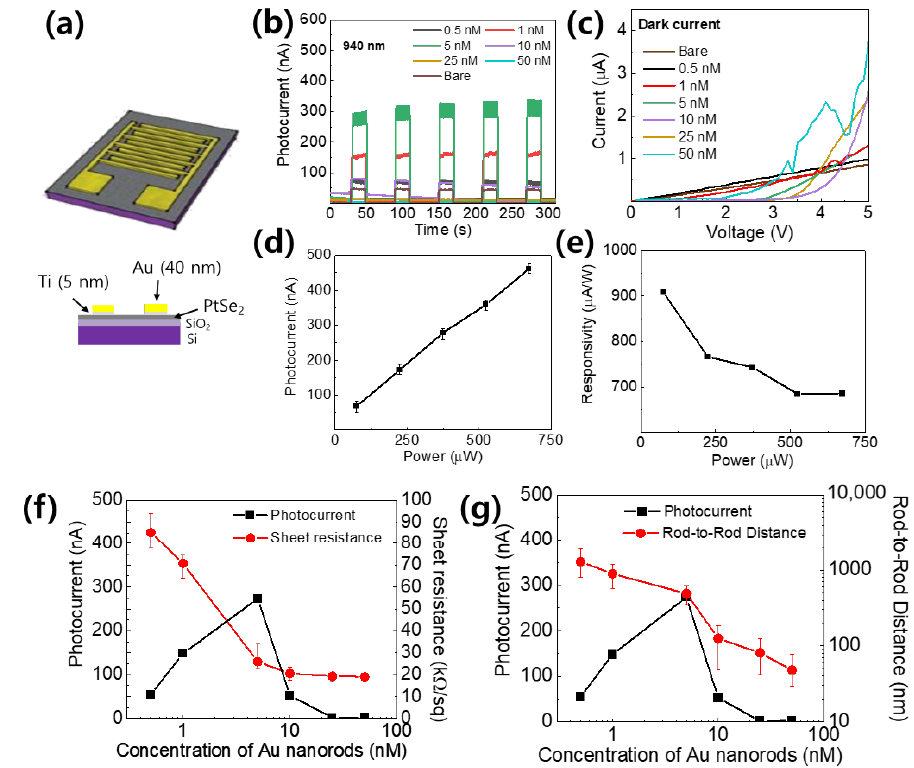
Figure 3. ( a ) Schematic of a comb-structure electrode. ( b ) Time-dependent photoresponse of Au nanorods of each concentration/2D PtSe 2 at 940 nm. ( c ) Dark current of each concentration of Au nanorod/2D PtSe 2 . ( d ) Power dependence of photocurrent from 5 nM Au nanorod/2D PtSe 2 . ( e ) Responsivity of 5 nM Au nanorod/2D PtSe 2 . ( f ) Relationship between concentration of the Au nanorod solution and sheet resistance of Au nanorod/2D PtSe 2 . ( g ) Relationship between concentration of the Au nanorod solution and rod-to-rod distance.